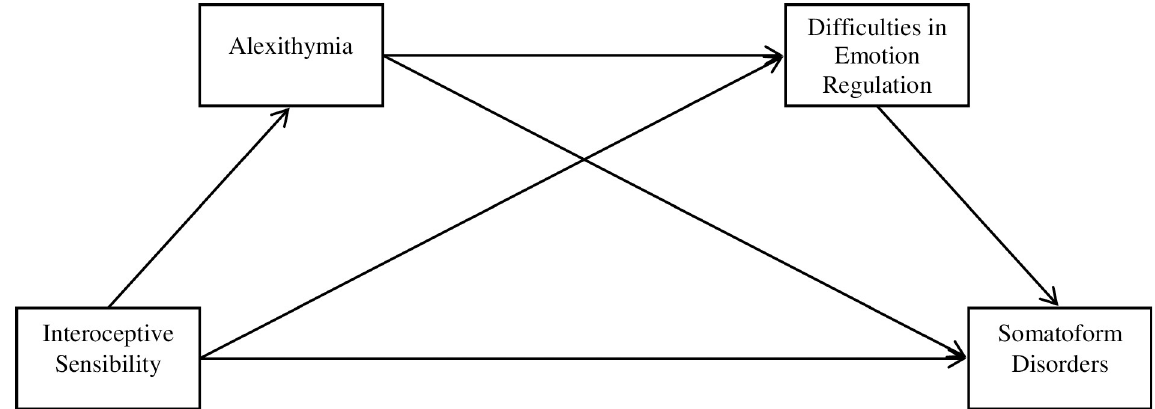
Fig 1. A graphical model presenting the nature of dependencies between interoceptive sensibility (autonomic reactivity), alexithymia, and difficulties in emotion regulation in explaining an inclination to somatoform disorders.